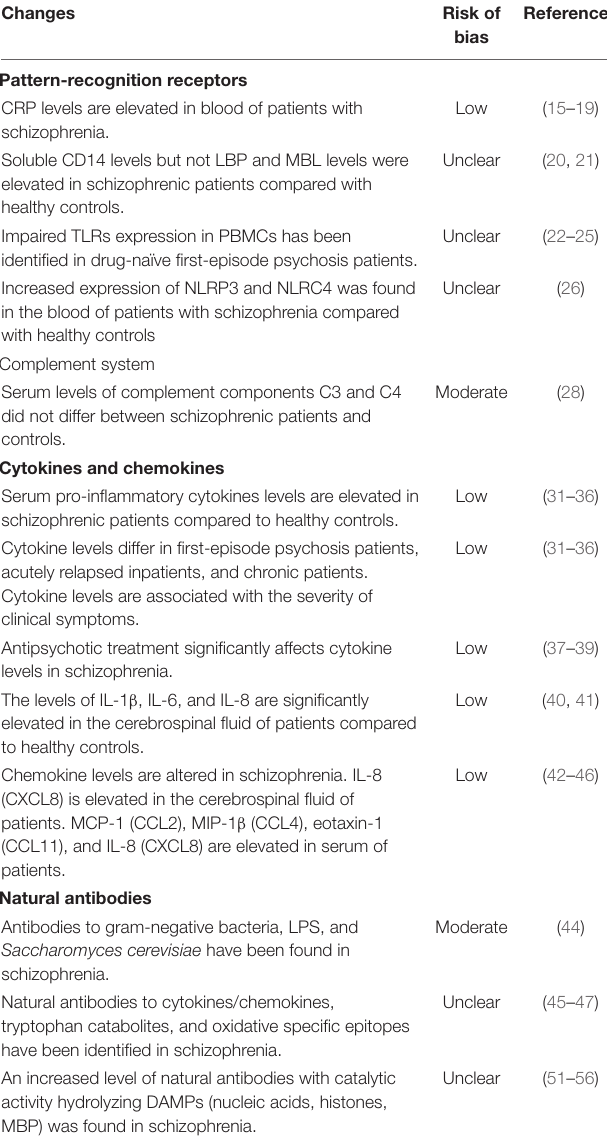
TABLE 2 | Abnormalities of the molecular components of the innate immune system in